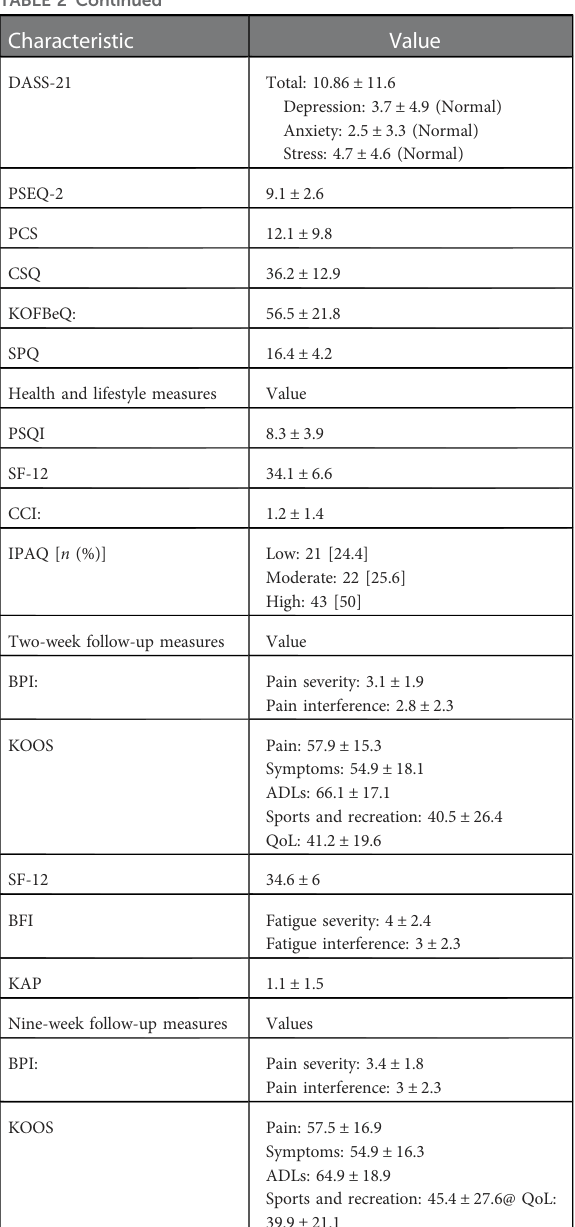
TABLE 2 Baseline measures of included participants a